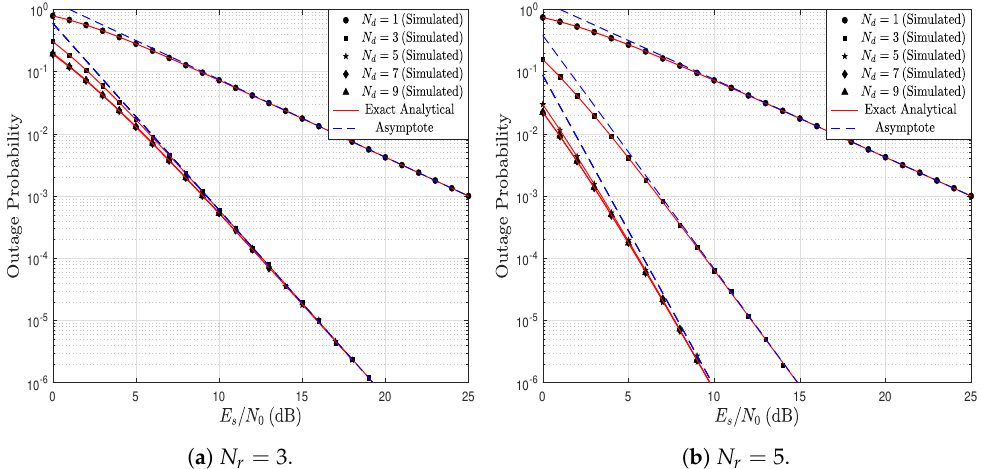
Figure 5. OP as a function of E s / N 0 , parameterized by N r and N d , considering k r = 2, k d = 2.5, and λ r = λ d = 1.